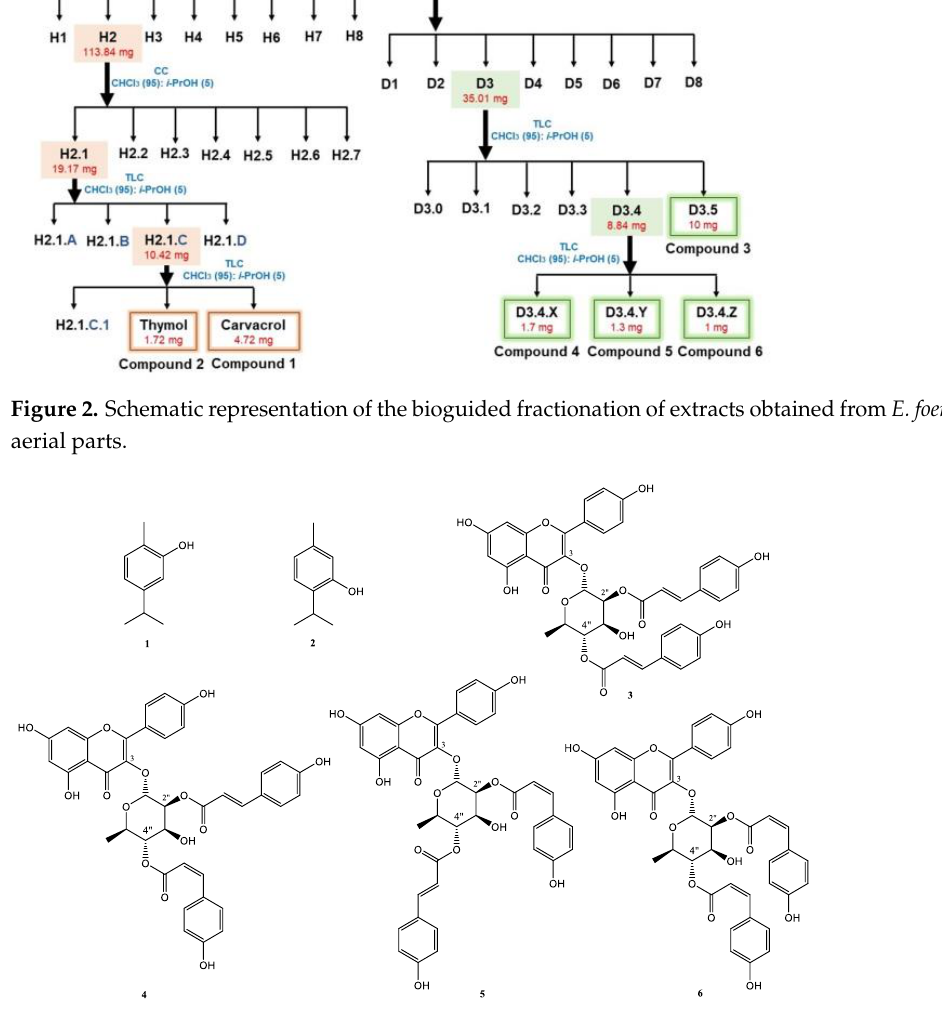
Figure 2. Schematic representation of the bioguided fractionation of extracts obtained from E. foe- minea aerial parts.